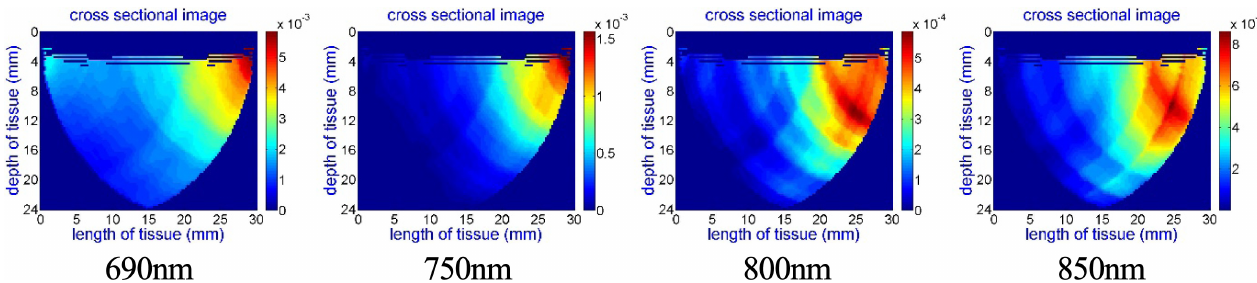
Fig. 13. Case study #2: reconstructed images from collected data using the DOB-Scan probe in four di®erent wavelengths, left breast,